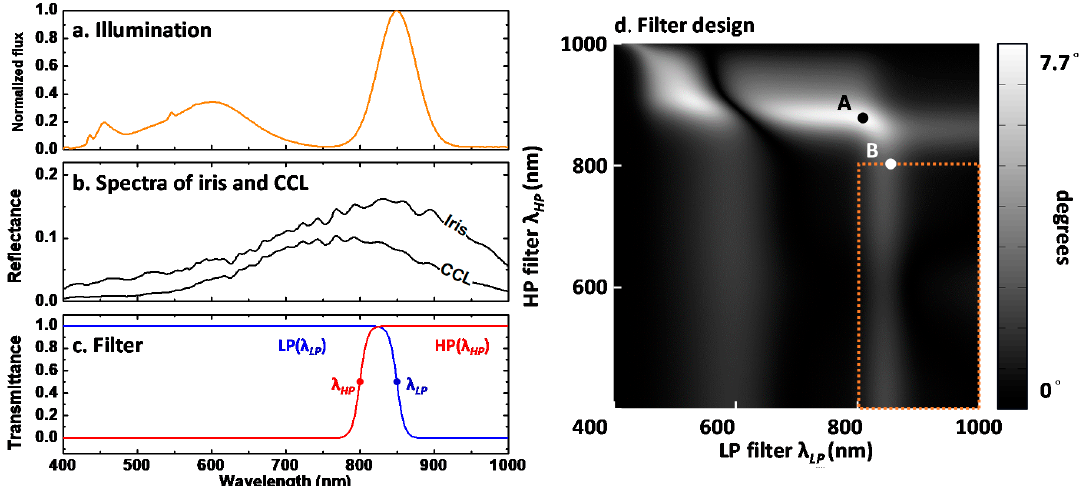
Figure 4. ( a ) The spectra of illumination; ( b ) the albedo of iris and CCL; and ( c ) the transmittance of two designed filters. The λ LP and λ HP , cutoff wavelength of each filter, were used as the design parameter; ( d ) The span angle space with respect to cutoff wavelength pairs. Orange rectangle represents the energy constrain. Although point A ( λ LP = 808 nm, λ HP = 879 nm) has largest span angle between two spectral components, but no crossed transmission window led to string energy loss. As a result, the point B ( λ LP = 850 nm, λ HP = 800 nm) was selected as the operation point, allowing a transmission window around 800–850 nm in NIR.